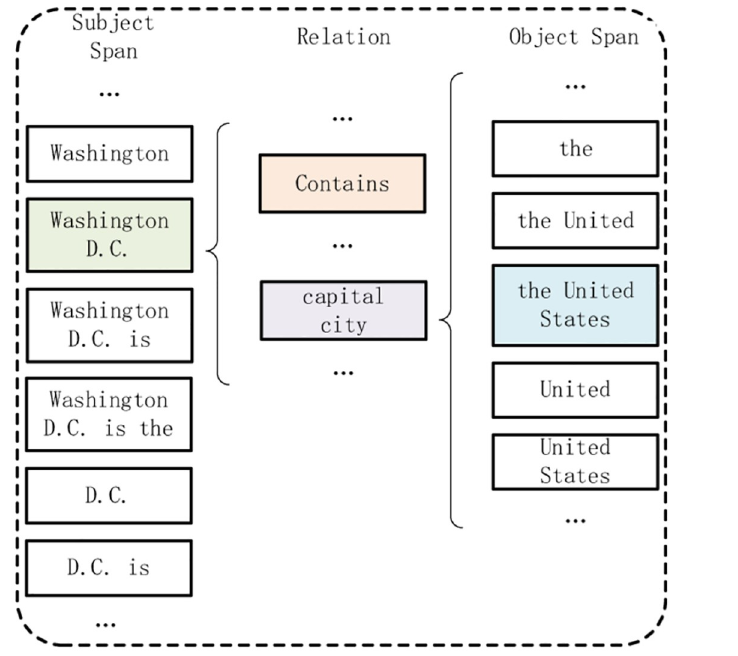
Fig 4. Flattened matrix of relation extraction of Fig